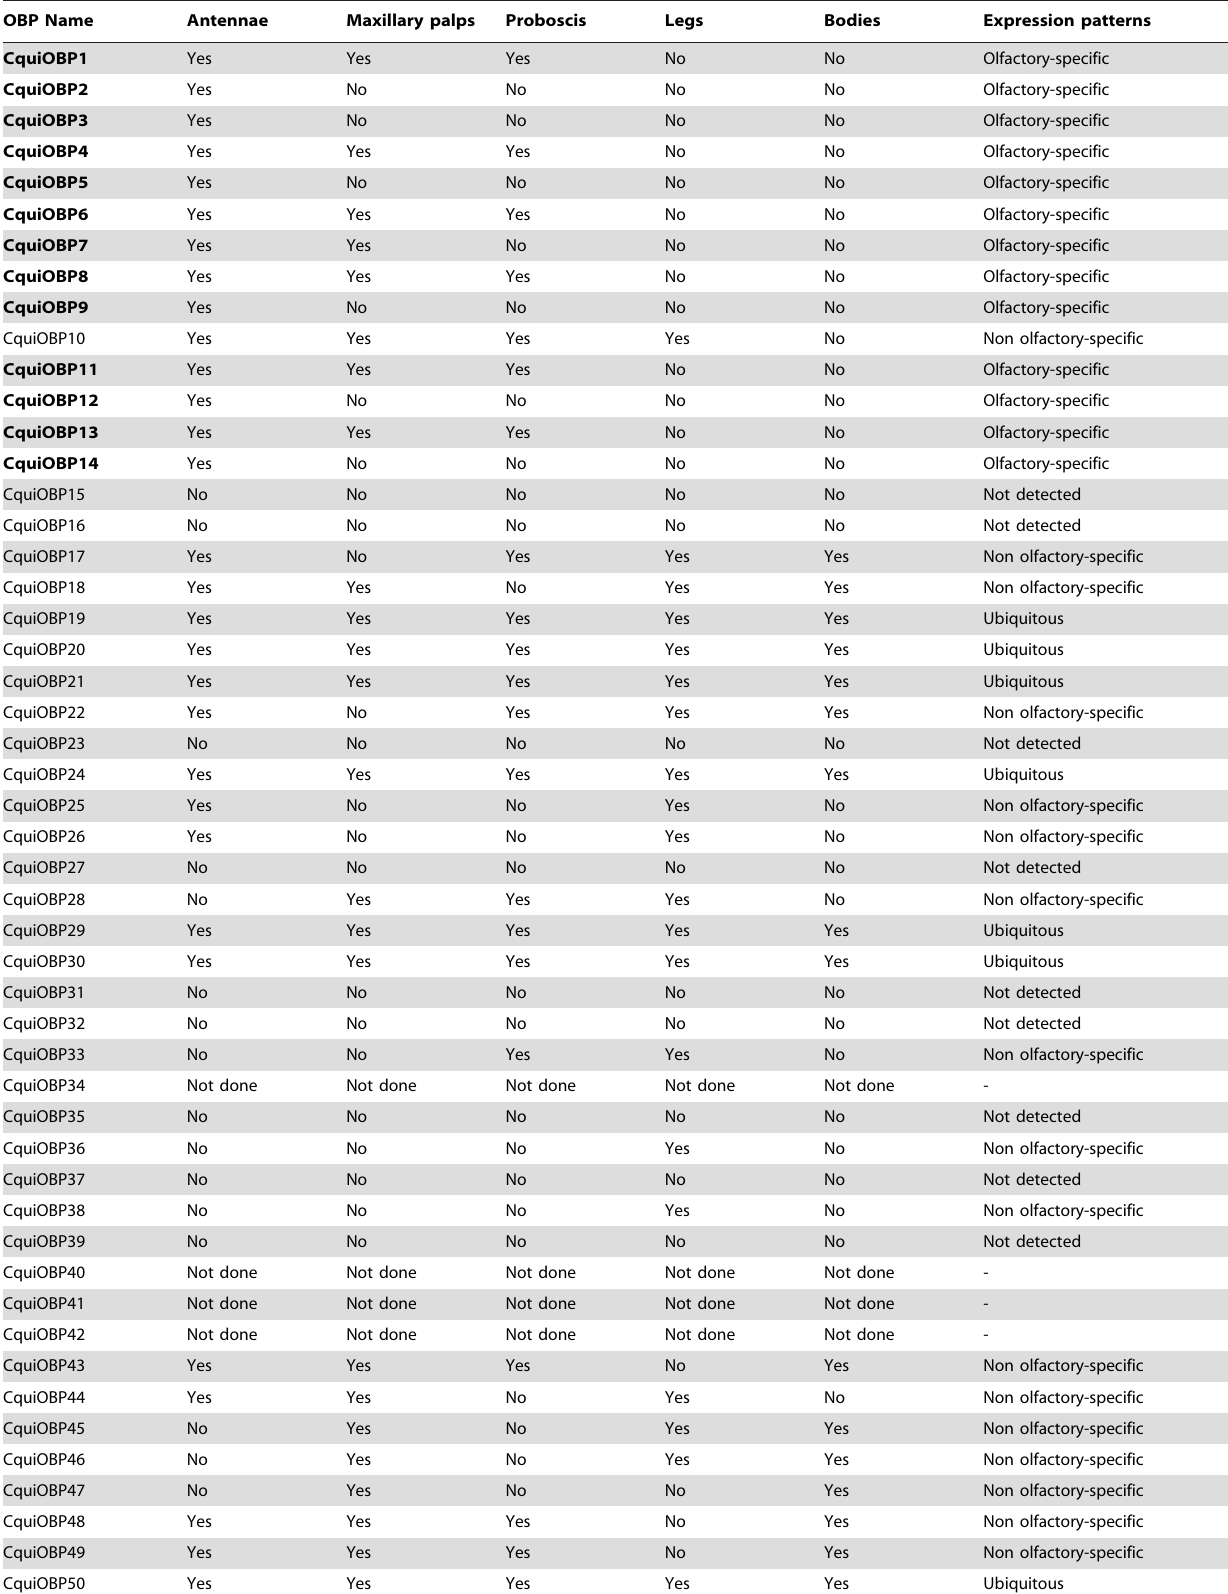
Table 4. Expression patterns of OBP genes by RT-PCR in adult